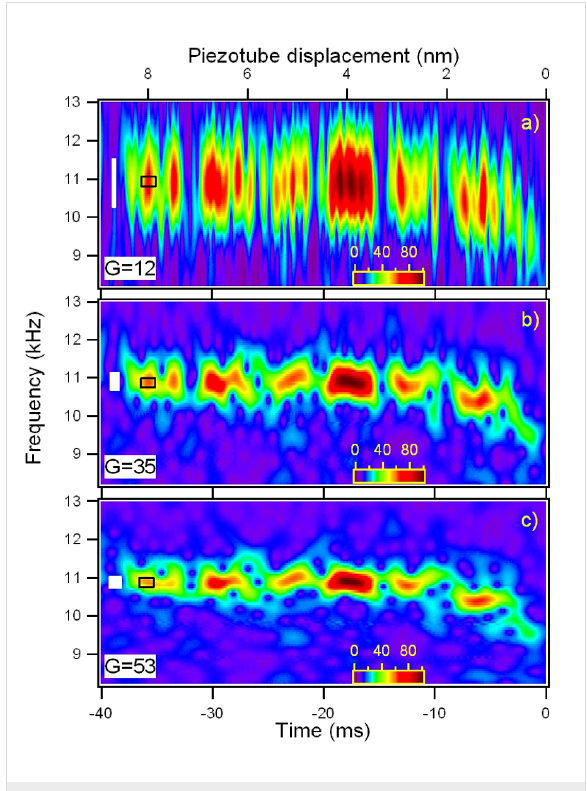
Figure 7: Wavelet transform of the cantilever thermal fluctuations around its instantaneous equilibrium position, using three mother wavelet with different shaping factor, a) G S =12, b) G S =35, c) G S =53. Increasing the shaping factor improves the frequency resolution but lowers the time resolution. The tip is moved toward the surface at a velocity of ≈ 225 nm/s until it jumps to contact (corresponding to the origin of the time axis). The wavelet coefficients | Wf ( f,t )| are coded in colorscale. The white boxes at the left sides are the Heisenberg boxes. The open boxes delimited by black lines represent the damped oscil- lator